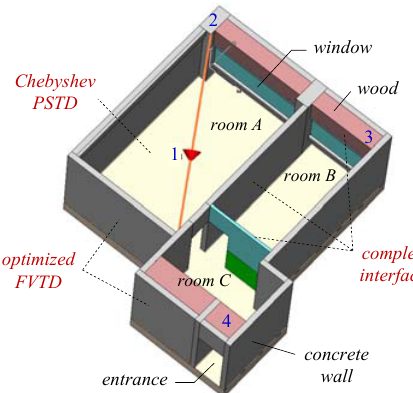
Figure 28: Perspective view of the investigated office area. Modeling regions: complex-interface schemes for the inner walls, the windows, and the wooden structures, optimized FVTD technique for the external walls, and PSTD algorithm for the interior of the domain.